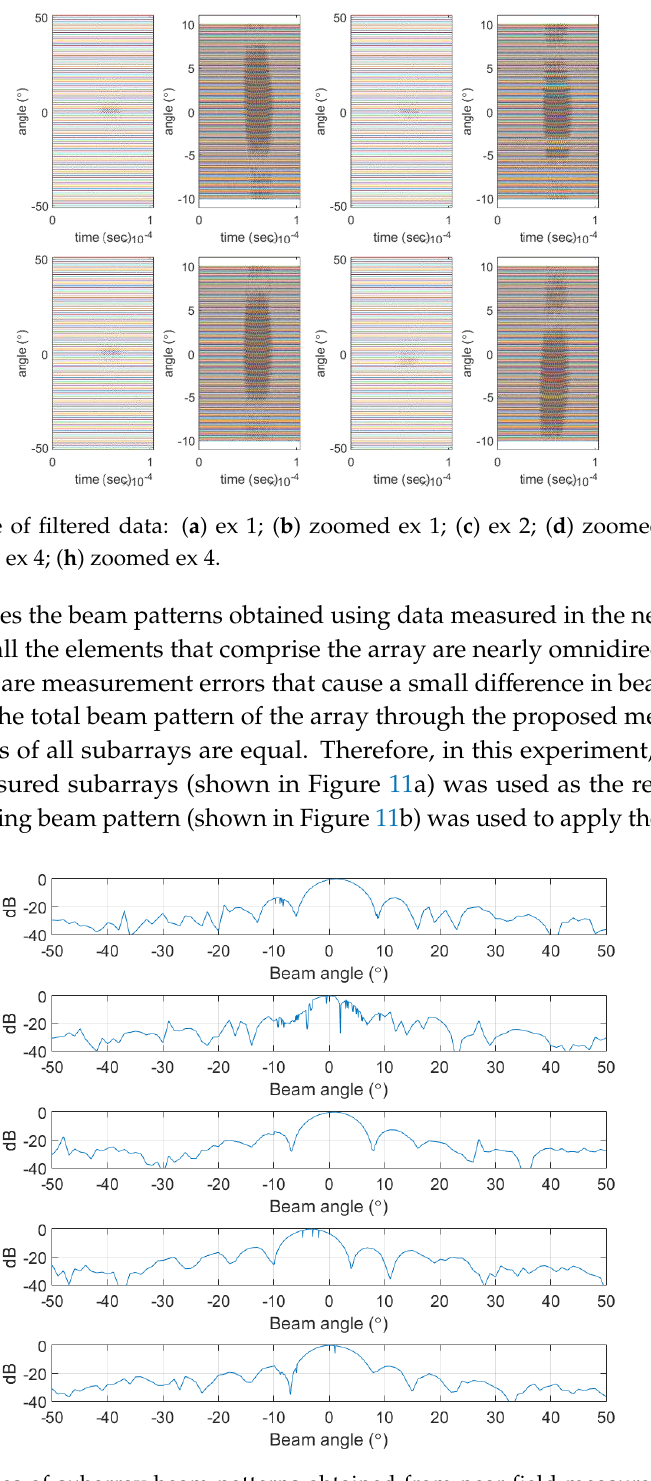
Figure 10. Examples of subarray beam patterns obtained from near-field measurements: ( a ) ex 1; ( b ) ex2; ( c ) ex3; ( d ) ex4; ( e ) ex5.